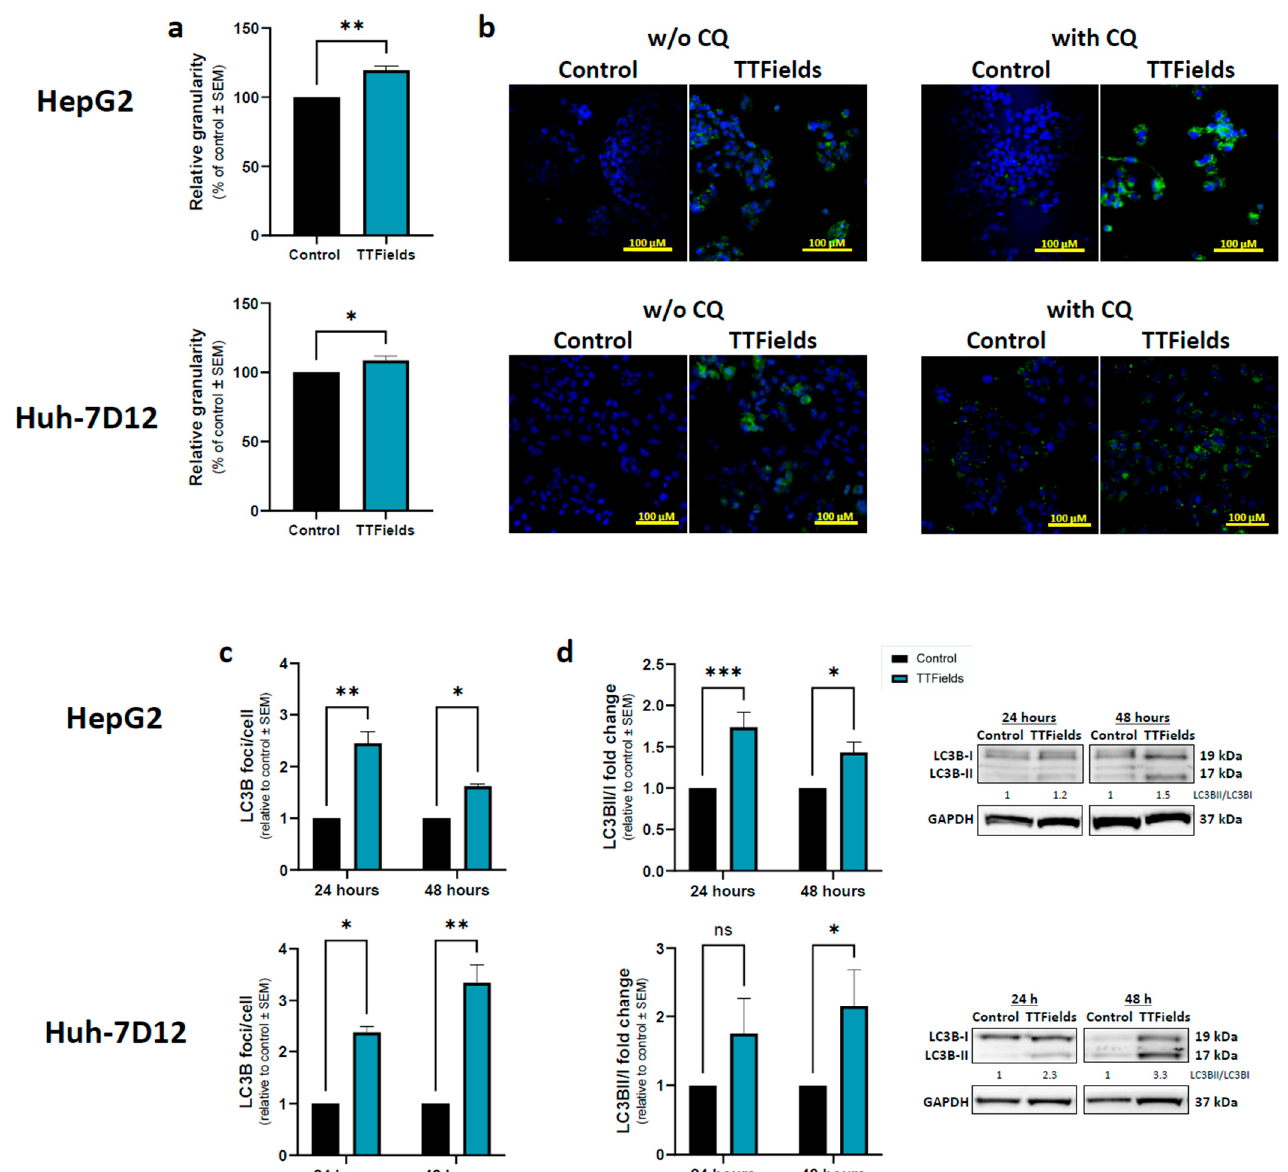
Figure 2. Effects of TTFields on autophagy levels in HCC cells. HepG2 and Huh-7D12 cells were treated with 150 kHz TTFields (1.0 and 1.7 V/cm RMS, respectively) for 72 h, and median side-scatter values were measured as representing changes in cellular granularity ( a ). Cells treated for 48 h were examined for LC3 foci formation by fluorescent microscopy, with or without addition of CQ during the last 3 h of the experiment ( b ), LC3 in green staining and DAPI in blue. Experiments performed with 24 or 48 h application of TTFields with addition of CQ during the 3 final hours of the experiments were quantified for LC3 foci formation by immunofluorescence ( c ), and for LC3-II to LC3-I ratio by immunoblotting ( d ). Values are mean (N ≥ 3) ± SEM. * p < 0.05, ** p < 0.01, and *** p < 0.001, relative to control; two-way ANOVA. ANOVA = analysis of variance; CQ = chloroquine diphosphate; DAPI = 4 ′ ,6-diamidino-2-phenylindole; HCC = hepatocellular carcinoma; ns = non-significant; RMS = root mean square; SEM = standard error of the mean; TTFields = Tumor Treating Fields.